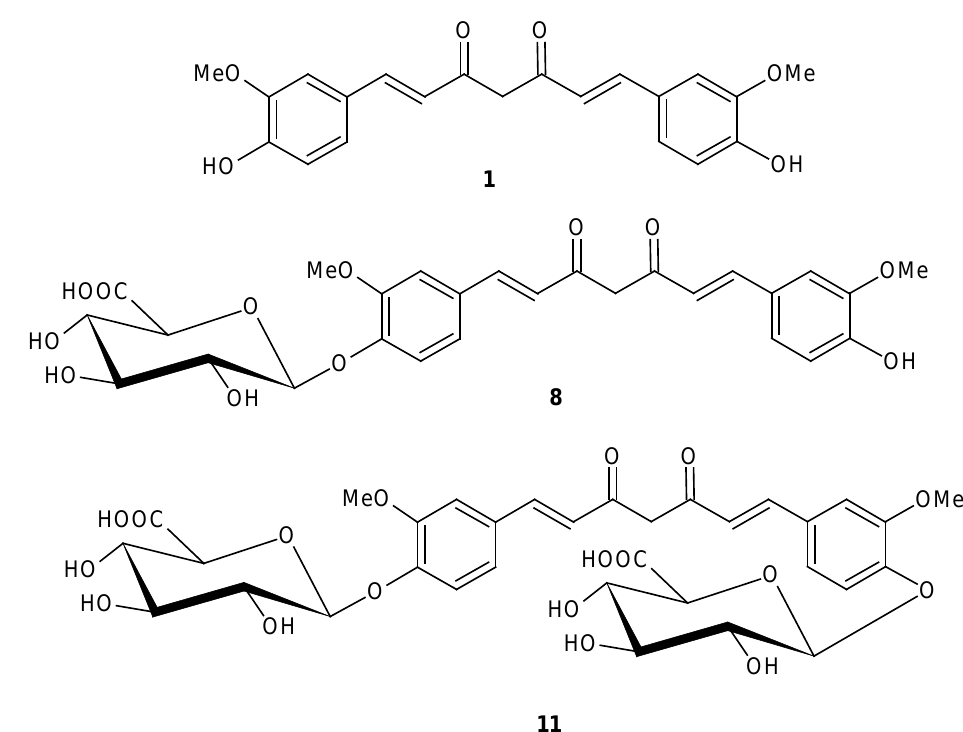
Figure 1. Chemical structures of Curcumin ( 1 ), curcumin monoglucuronide ( 8 ) and curcumin diglucuronide ( 11